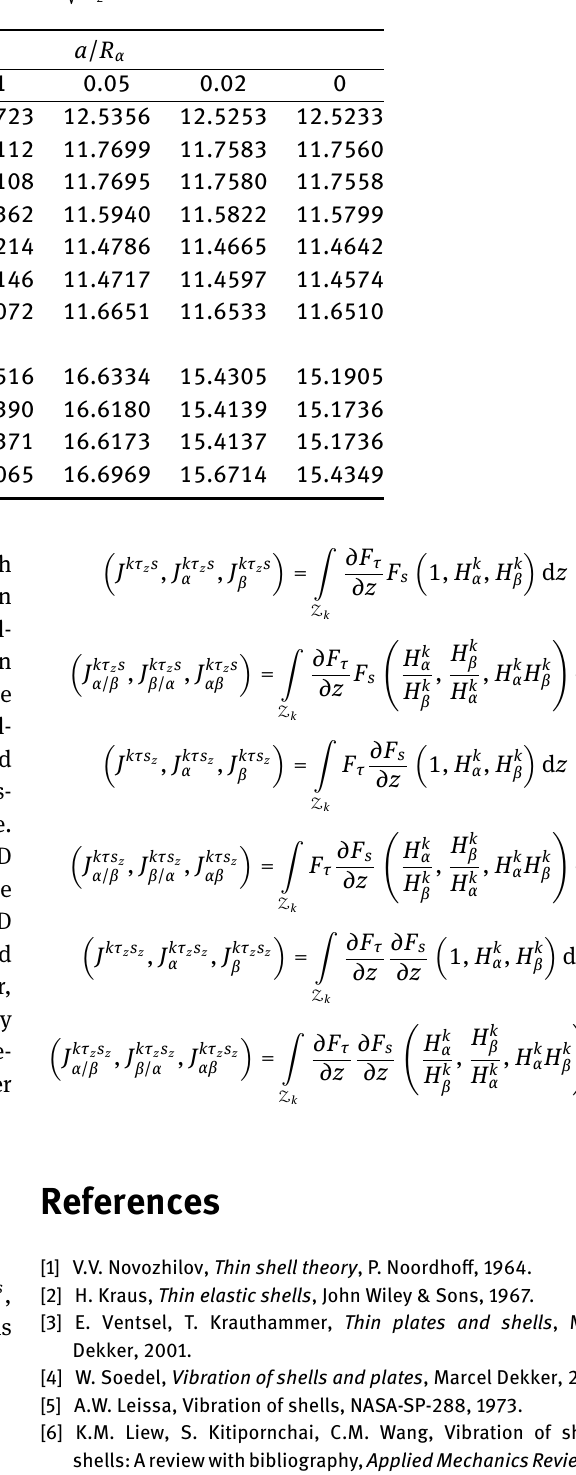
Table 6: Non-dimensional fundamental frequency parameters λ = ω ( a 2 / h )